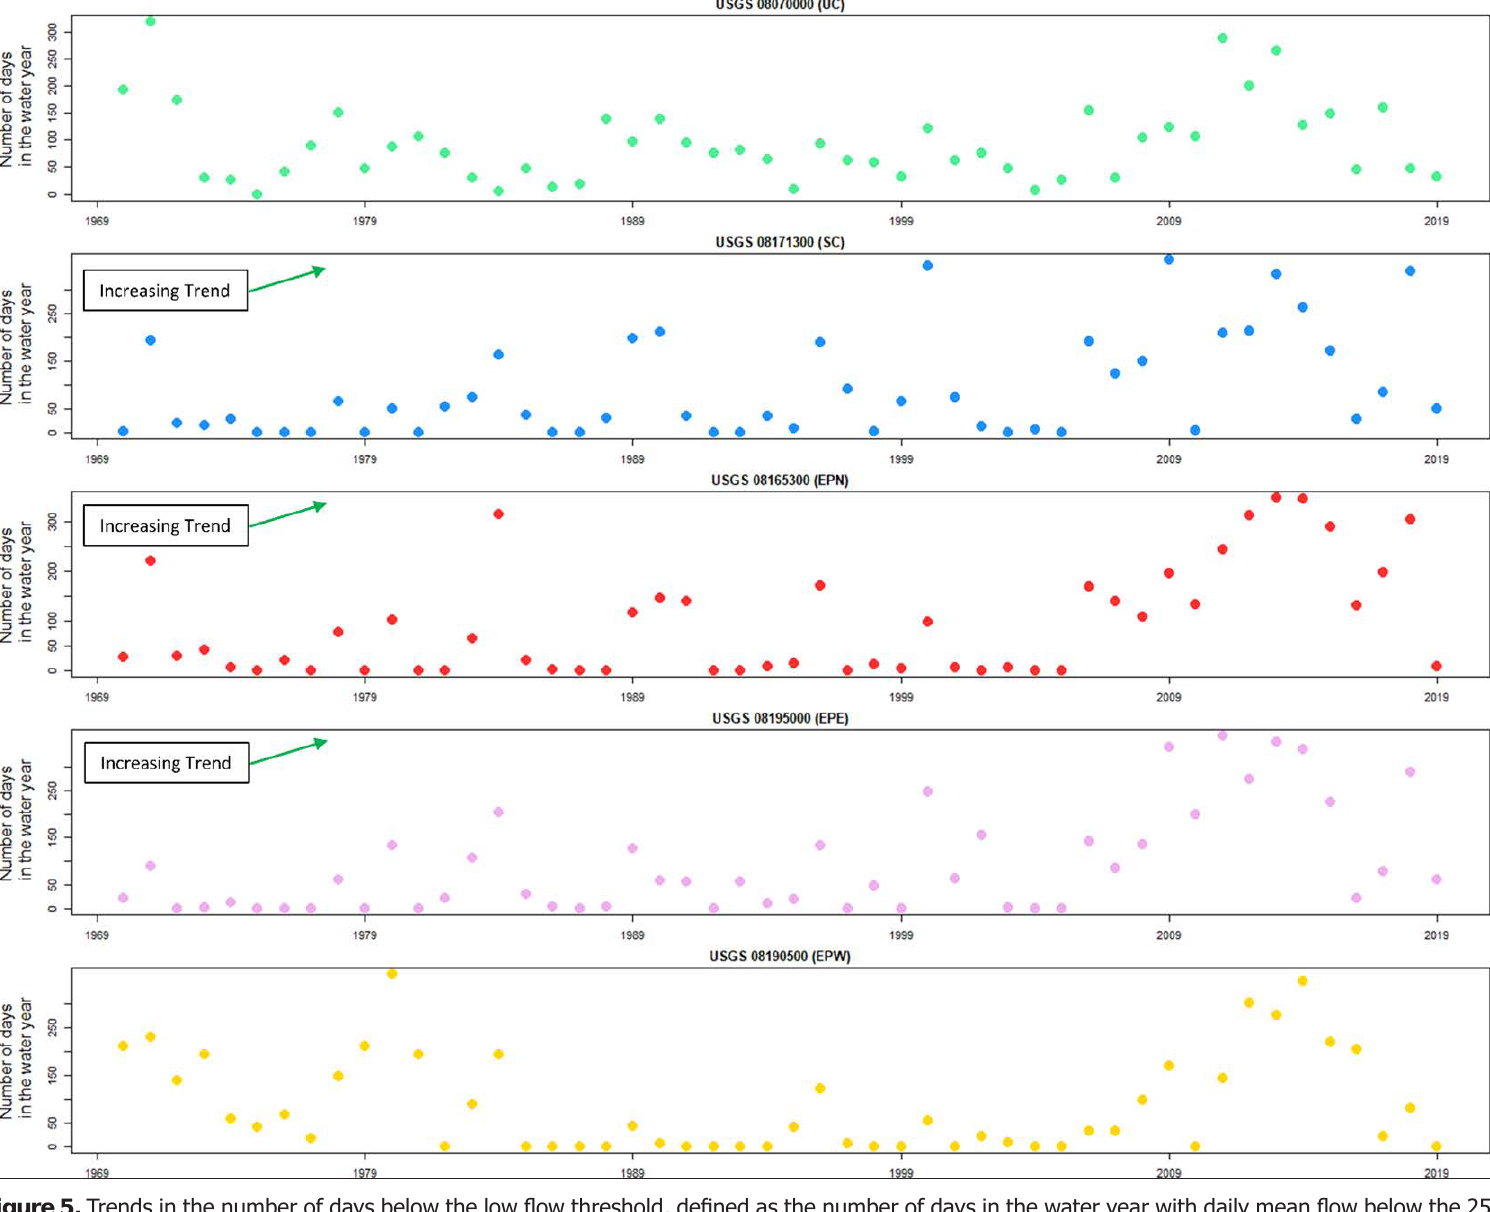
Figure 5. Trends in the number of days below the low flow threshold, defined as the number of days in the water year with daily mean flow below the 25th percentile of the overall time period (gage 08195000 is used to represent the EPE